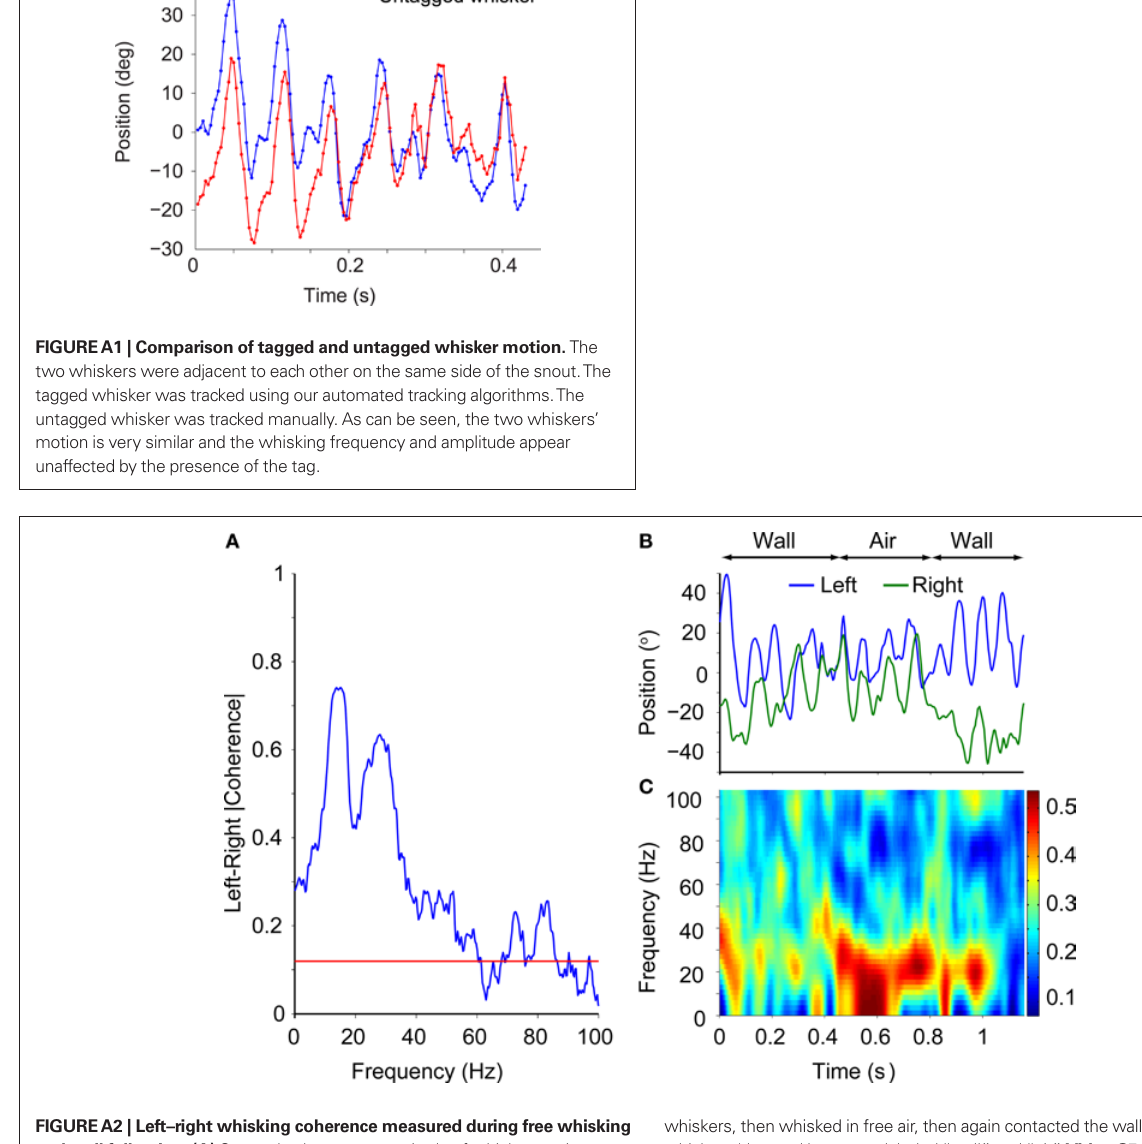
FigurE A2 | Left–right whisking coherence measured during free whisking and wall following. (A) Spectral coherence magnitude of whisker motion measured on the left and right sides of the snout. Whisking data was taken from 21 hunting trials prior to cricket attack. For each trial one whisker on each side of the snout was tagged and tracked. During exploration of the hunting arena, whisker motion on the two sides was largely coherent ( ∼ 75% coherent at whisking frequencies). The second coherence peak at approximately 28 Hz is due to harmonics of the 14-Hz whisking ( n = 42 1-s whisking segments, red line denotes the theoretical 5% confidence level). (B) Single example of left and right whisker motion while the shrew first contacted a wall with its right